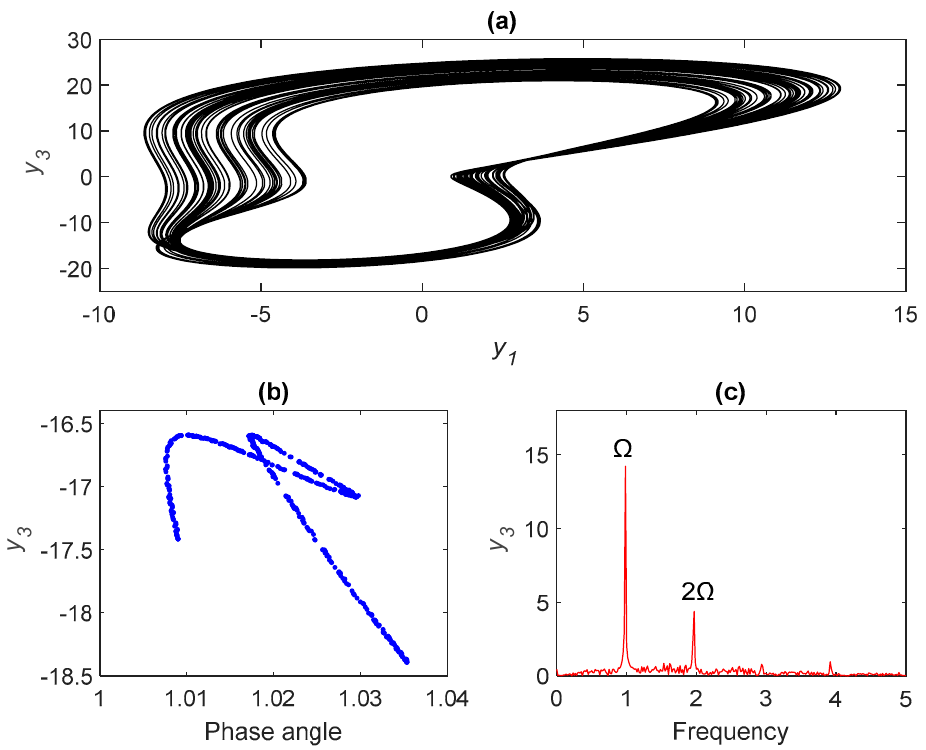
Figure 7. Chaotic motion for σ = 4.32: ( a ) phase portraits, ( b ) Poincare maps, and ( c ) frequency spectra.